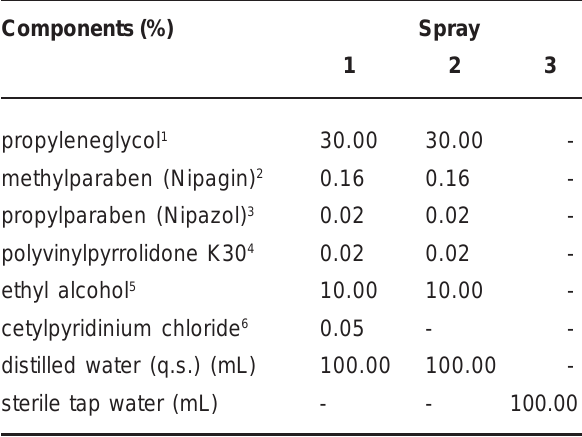
TABLE 1- Composition of the tested